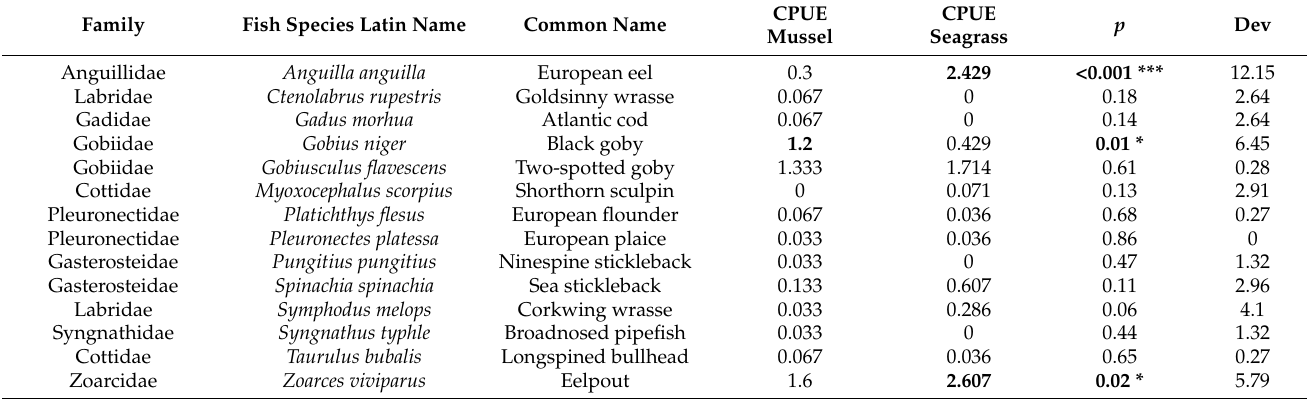
Table 1. Comparison of fish species abundances estimated using catch per unit effort (CPUE) data from seagrass meadows and mussel reefs in the Øresund between Denmark and Sweden. The p values were derived from the univariate analyses of deviance with 999 resampling iterations, comparing the number of each species separately in each habitat. The bold cells indicate the statistically significant differences and the asterisks show the level of significance, where *** p < 0.001 and * p <